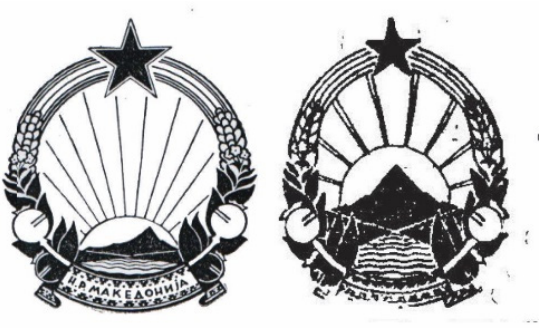
Figure 1. The state emblem of the People’s Republic of Macedonia 1946 ( left ) and 1947–2009 ( right ). The Constitution of the Republic of Macedonia, dated 17 November 1991, did not determine the state emblems but provided that they be determined by a law to be adopted by a two-thirds majority vote. According to the Constitutional Law, this should have happened within six months. A Public competition was held for the coat of arms, flag, and anthem. The anthem remained the same, but the Constitutional Commission was not content with arms and flag proposals. The Commission asked the three “winning” designers to submit further proposals including a new design of a golden sun on a red field for the arms and for the flag. The proposal submitted by codename “Feniks 1992” (Kostadin Tanchev Dinkata) was accepted and included in the Commission’s official Draft Law on the Coat of Arms submitted by the MPs Tito Petkovski, Zoran Krstevski, and Kiro Popovski on 20 June 1992, as well as a proposal for a flag with the same sun (Figure 2). The draft proposal states: “The coat of arms of the Republic of Macedonia is a shield with a red field enclosed with a yellow (golden) edge. In the middle of the shield is a yellow (golden) sun. The sun has 16 primary rays that break into 32 rays, 16 of which are at the top of the primary rays, and the other 16 are in the middle between primary rays. Under the shield is a ribbon on which is written ‘Pe п y блик a Ma к e дони ja’ (Republika Makedonija)’” 5 . The actual blazon is Gules, a sun in splendour with 16 rays, surrounded by circle of 32 secondary rays, Or.